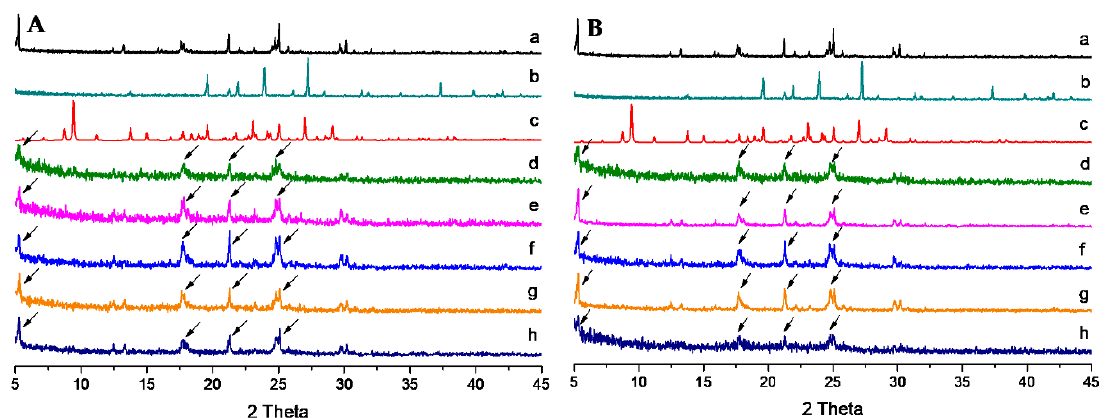
Figure 4. Comparison of PXRD patterns: A. (a) NTZ, (b) GLU, (c) NTZ-GLU simulated from SCXRD data. Solids recovered after powder dissolution tests of NTZ-GLU under non-sink conditions in pH 7.5 phosphate buffer solution with pre-dissolved 0.5% w / v HPMC after (d) 1 min, (e) 2 min, (f) 3 min, (g) 4 min, (h) 5 min B. (a) NTZ, (b) GLU, (c) NTZ-GLU simulated from SCXRD data. Solids recovered after powder dissolution tests of NTZ-GLU under non-sink conditions in pH 7.5 phosphate buffer solution with pre-dissolved 0.5% w / v Methocel ® 60 HG after (d) 1 min, (e) 2 min, (f) 3 min, (g) 4 min, (h) 5 min.